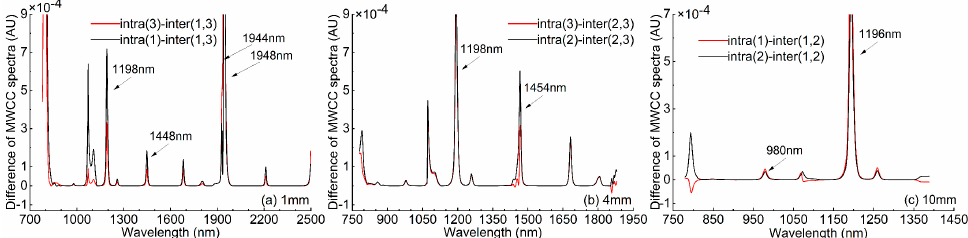
Figure 2. Difference spectra between intra-category and inter-category MWCC spectra: ( a ) 1 mm, 1–3 category, ( b ) 4 mm, 2–3 category, ( c ) 10 mm, 1–2 category.